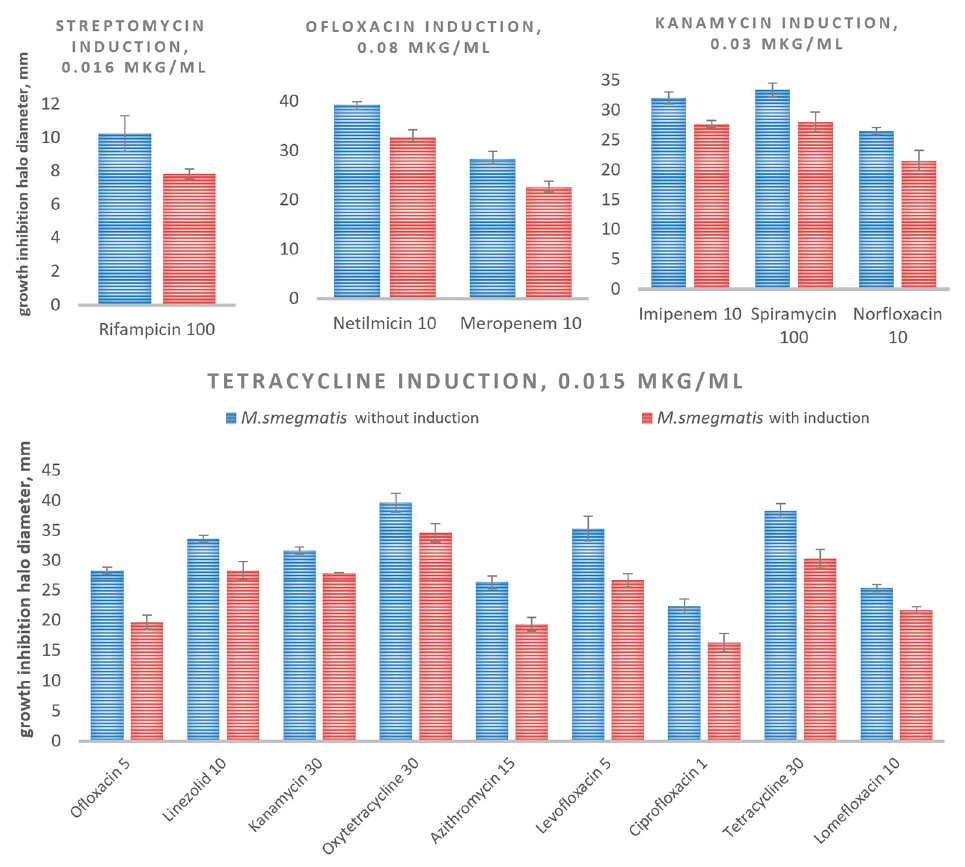
Figure 1. Diameters of growth inhibition halos produced by different antibiotics with and without induction by low doses of antibiotics on cultures of M. smegmatis . The columns represent the mean value, while the error-bars represent standard deviations (SD) from five independent experiments.